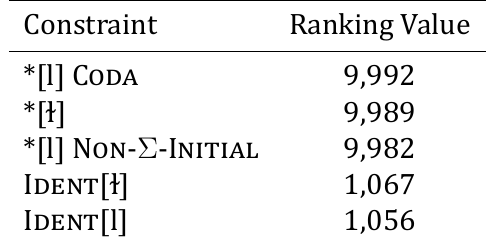
Table 10: Constraint ranking values at the stem level